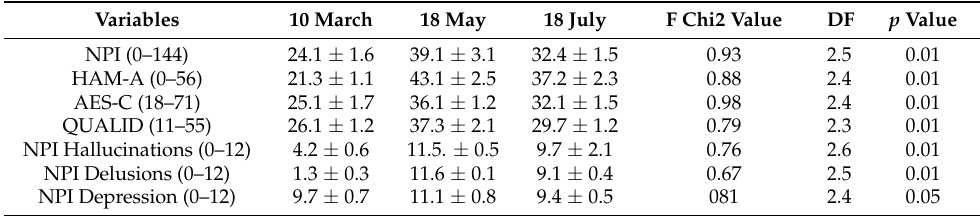
Table 5. Comparison of mean value and SD of the defined neuropsychological scores in Group B.